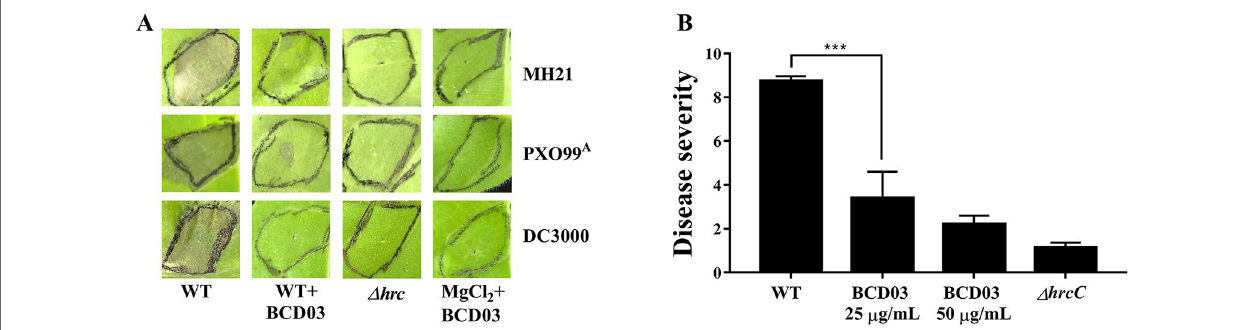
FIGURE 3 | (A) BCD03 suppression of hypersensitive responses in Nicotiana tabacum triggered by pathogenic bacteria. A. citrulli MH21, X. oryzae pv. oryzae PXO99 A , P. syringae pv. tomato DC3000 and their T3SS mutants, with or without BCD03 (25 µg/mL added 2 h before infiltration), were infiltrated into the leaves (3 × 10 8 cfu/mL for MH21 and PXO99 A , 3 × 10 6 cfu/ml for DC3000) then the response was photographed at 18 h post inoculation. The control group was treated with 10 mM MgCl 2 mix with 25 µg/mL BCD03. Photos from one of three biological replicate experiments are shown. (B) Effect of BCD03 on infection of A. citrulli MH21 on melon seedlings. Germinated melon seeds were dipped in bacterial suspension at 3 x 10 8 CFU, supplemented with 0, 25 or 50 μg/mL BCD03, respectively. Disease severity was investigated 12 days after sowing. Disease ratings are defined using a scale-based symptom appearance as described in Methods section. The experiments were repeated twice with three biological replicates. Each replicate contained 5 seedlings. Statistically significant differences (Two-way ANOVA) were observed between wild type treated groups and other groups. P-value < 0.01